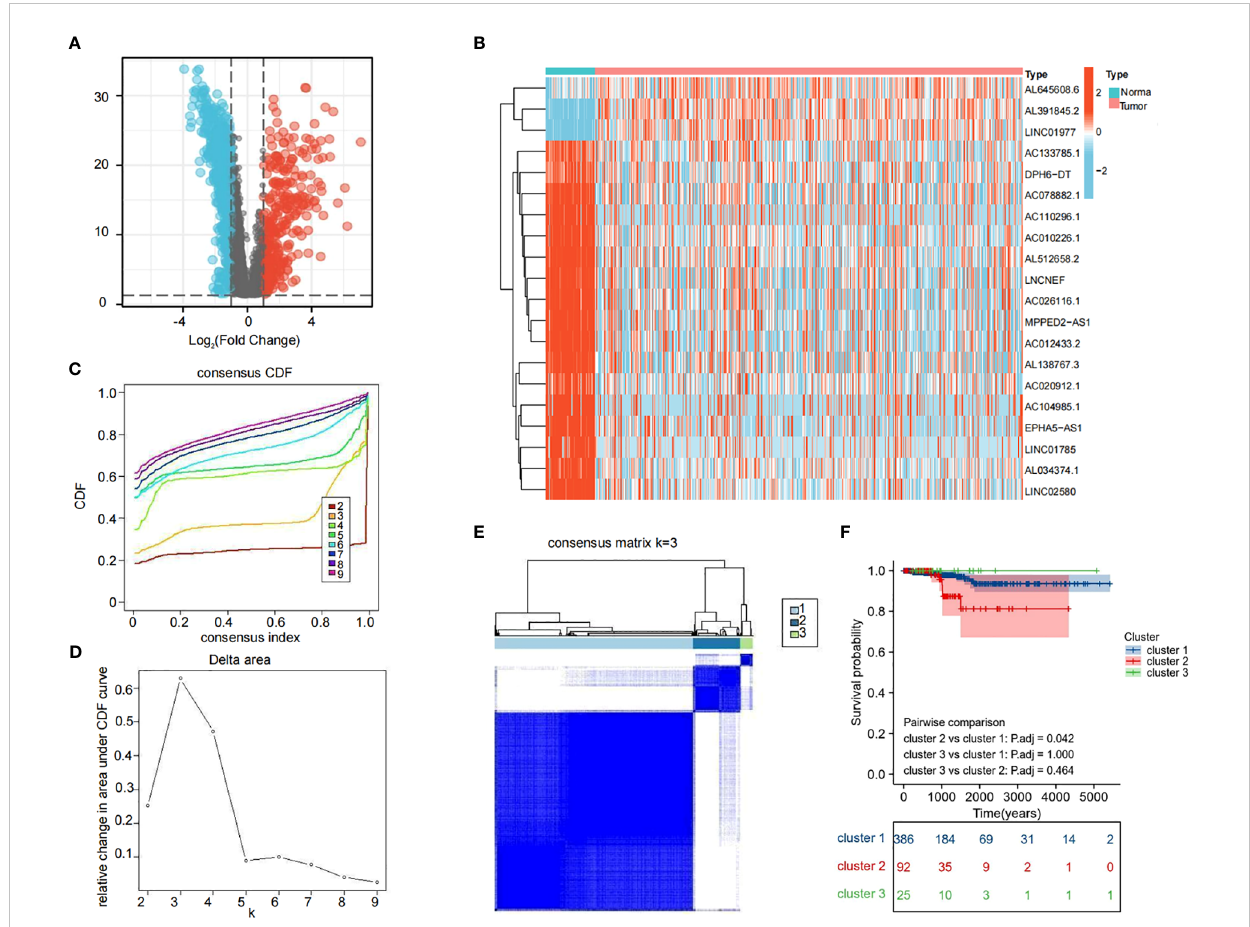
FIGURE 3 Cluster analysis of LRLs. (A) Distribution of LRLs in tumor and normal groups with log 2 FC >1 for the red bubble and log 2 FC<-1 for the blue bubble. The p-value for both red and blue distributions is less than 0.05. (B) Differential distribution of 50 differentiated LRLs in normal vs. tumor groups. (C, D) Consensus clustering CDF when the data is divided into 2-9 clusters. (E) TCGA-THCA cohort RNA expression quanti fi cation data were divided into three different clusters. (F) KM curves for the three clusters. The OS of cluster 2 was signi fi cantly lower than that of cluster 1 (P<0.05). P<0.05 was considered signi fi